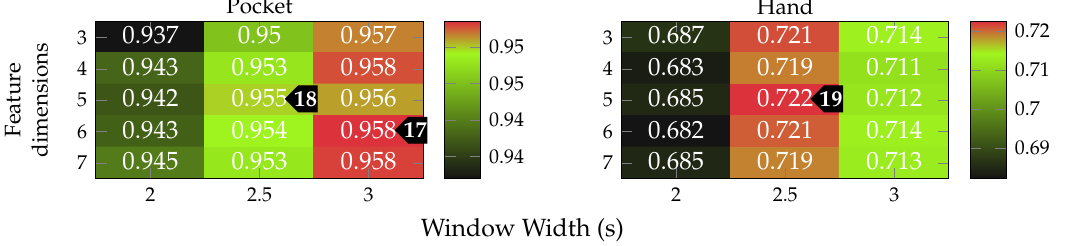
Figure 25. Classification accuracies achieved for different window widths and remaining dimensions after the LDA, while using two-channel acceleration for both pocket-case and